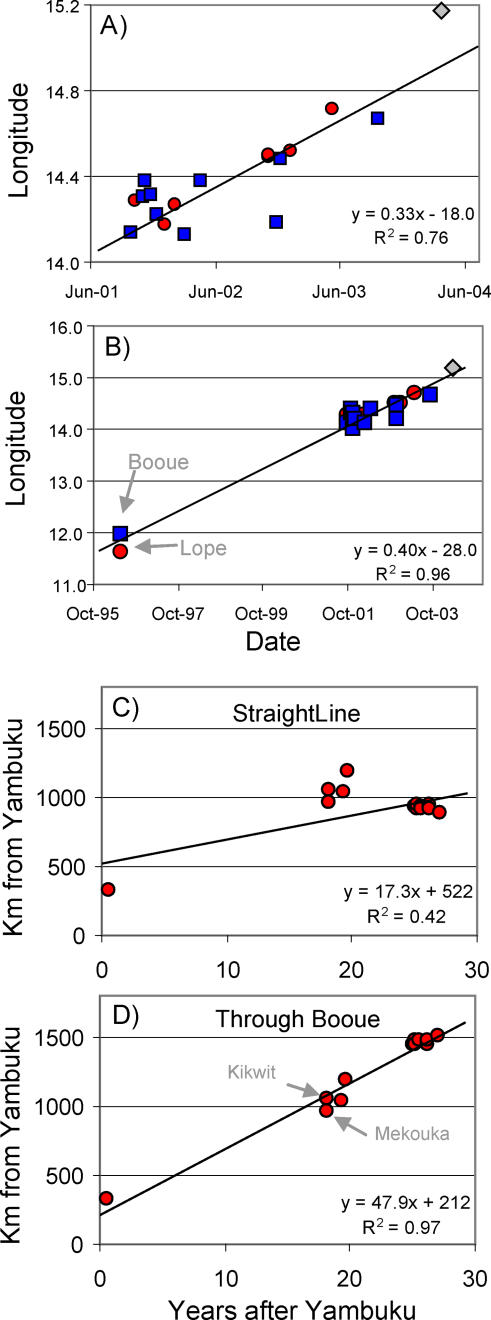
Spatial Spread of ZEBOV(A) Relationship between date and longitude of outbreaks in Gabon-Congo border area. Blue squares, human outbreaks [2] and 2003 outbreak at Mbandza village; red circles, animal carcasses testing positive for Ebola [18]; gray diamonds, ape die-off at Ibounji\Lokoue clearing. Regression line is for pooled data. Analyzed separately, human outbreaks and Ebola+ animal carcasses both show significant correlations between longitude and date (human outbreaks n = 12, R2 = 0.48, p = 0.01; animal carcasses n = 13, R2 = 0.91, p < 0.001).(B) Added are 1996 human outbreak at Booué and Ebola+ chimpanzee carcass from nearby Lope [1]. The lack of reported human outbreaks between 1996 and 2001 may simply reflect the extremely low village density between Booué and Mendemba (Figure 1).(C) Time after Yambuku versus straight line distance from Yambuku to all subsequent human outbreaks, including [2,14] and Mbandza village (R2 = 0.42, n = 17, p = 0.005).(D) Same as (C) but with distance from Yambuku to the recent Gabon-Congo border outbreaks measured as passing through Booué (R2 = 0.97,n =17, p < 0.001). All figures include outbreak sites cited [2,14] for which no ZEBOV-GP sequences were publicly available.